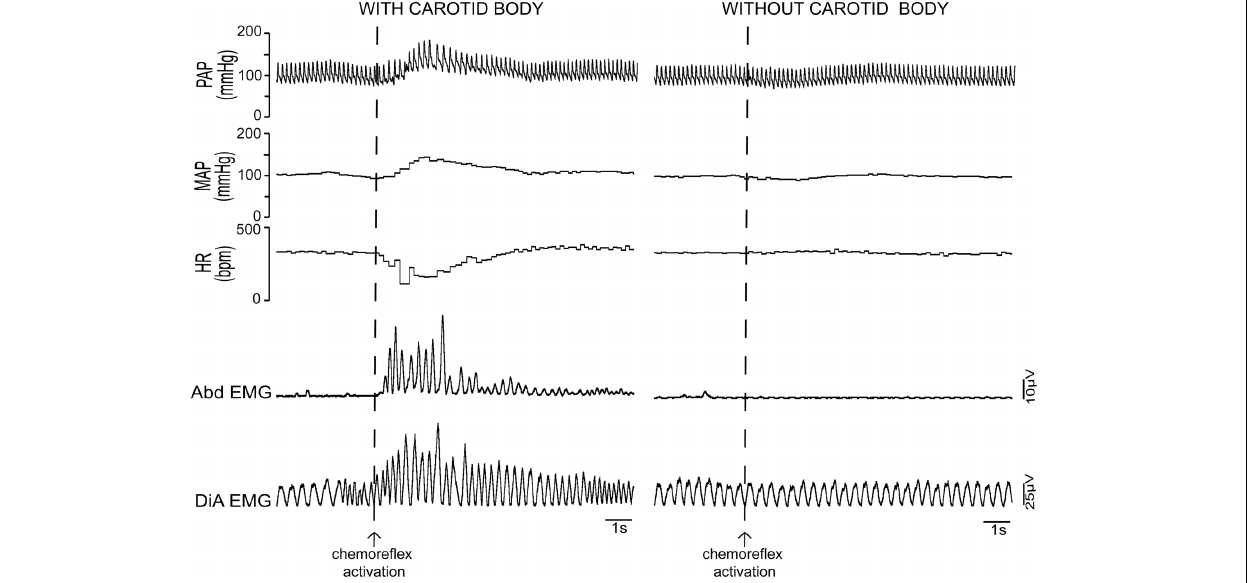
the strong changes in the eletromyographic (EMG) signals of the abdominal (Abd) and diaphragm (DiA) muscles. In rats that have been subjected to carotid body denervation, the hypertensive, bradycardic and respiratory responses to hypoxia are completely abolished. This fact highlights the essentiality of the peripheral chemoreflex pathway for the cardiorespiratory responses to systemic